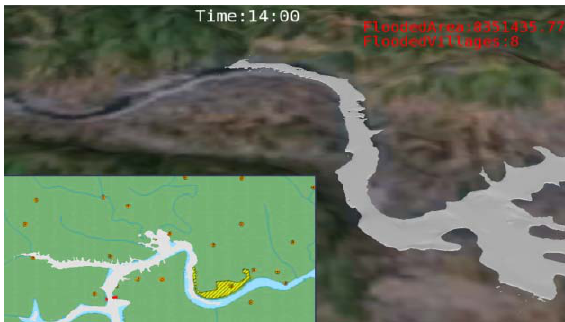
Figure 7. The analysis on dam-break flood evolution